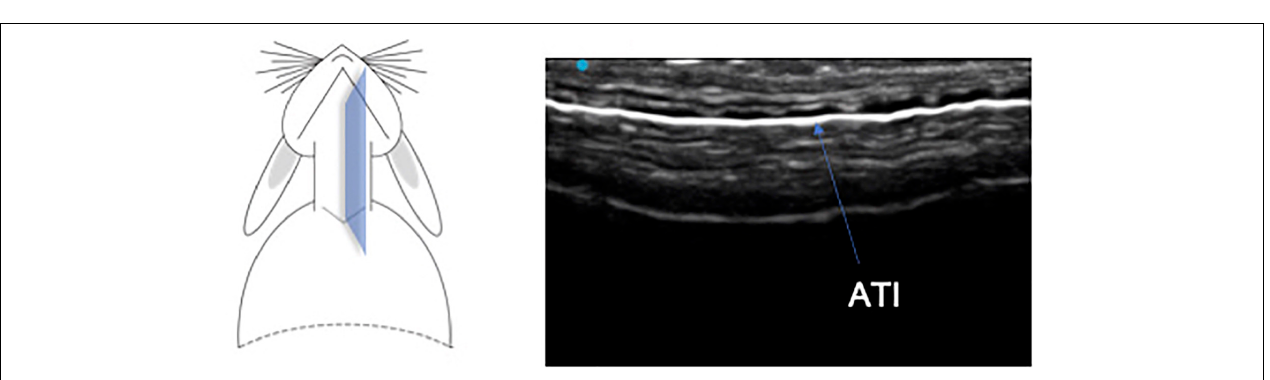
FIGURE 2 | Transverse plane of the trachea at the caudal cervical level at the inlet of the thoracic cage. A – Trachea, B – Clavicle bone, C – Common Carotid artery, E – Esophagus.